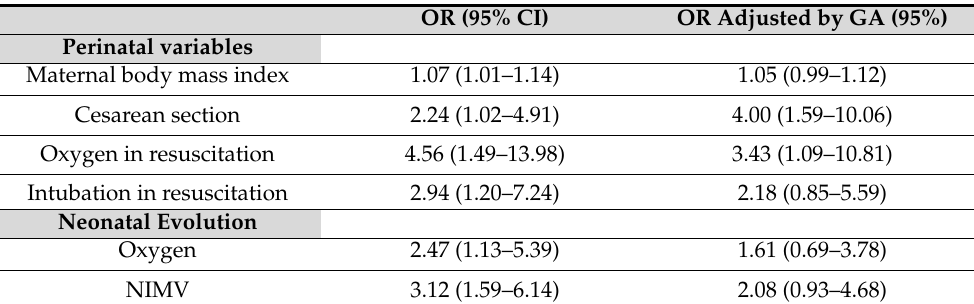
Table 3. Multivariate analysis to identify independent risk factors for HPTH. Crude Odds Ratios (OR) and OR adjusted by gestational age (GA) are